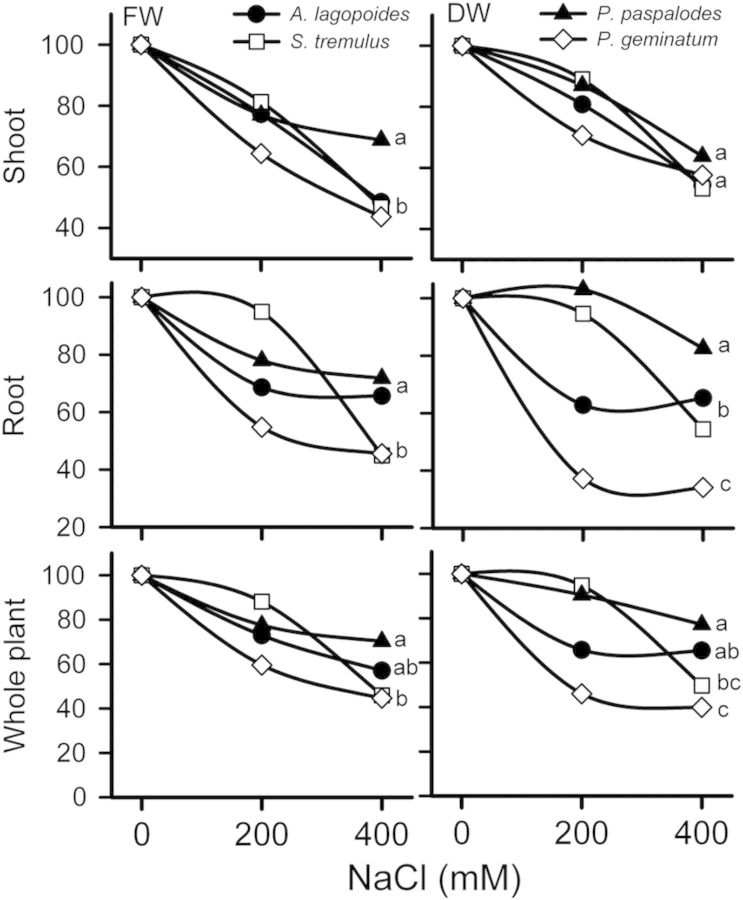
Percent change in the fresh weight (FW) and dry weight (DW) at shoot, root and whole-plant levels of the salt-excreting (A. lagopoides, S. tremulus) and non-excreting (P. paspalodes, P. geminatum) grasses grown under increasing salinity treatments (0, 200 and 400 mM NaCl). Different letters represent significant differences among species at P < 0.05 (Bonferroni test).